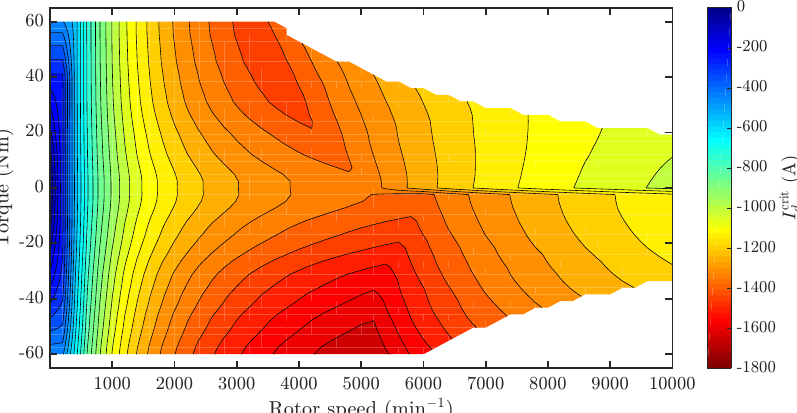
Figure 14. Peak transient current I crit